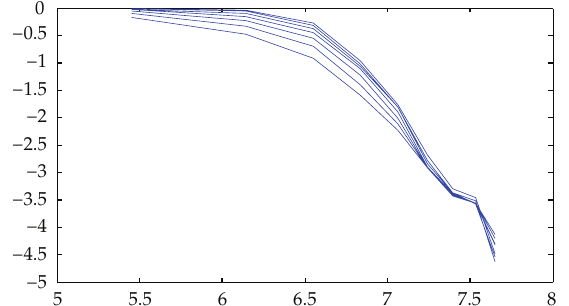
Figure 10: The fitting chart of rehabilitation group for NIHSS baseline fractal m (cid:8) 2.